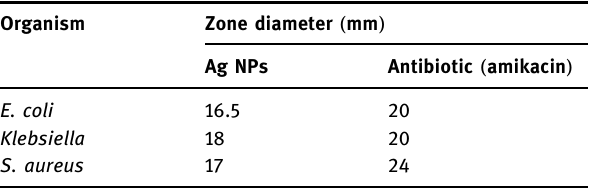
Table 1: The antibacterial activity of silver nanoparticles ( Ag NPs ) synthesized using natural honey.